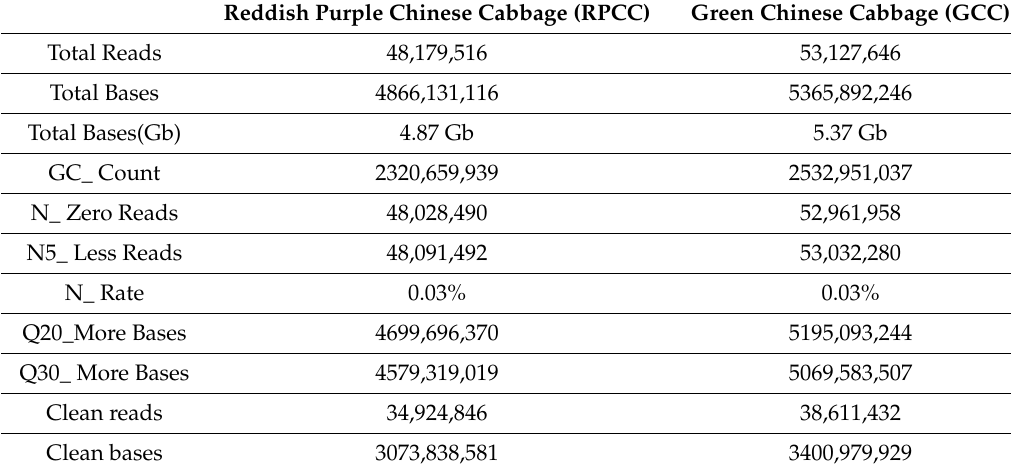
Table 2. Summary of RNA sequence